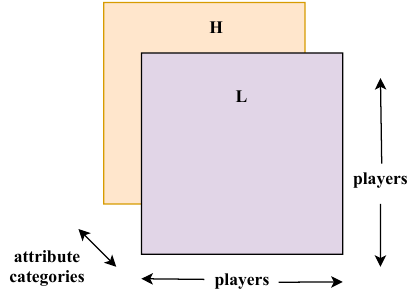
Figure 3. Tensor structure (Source: Authors).